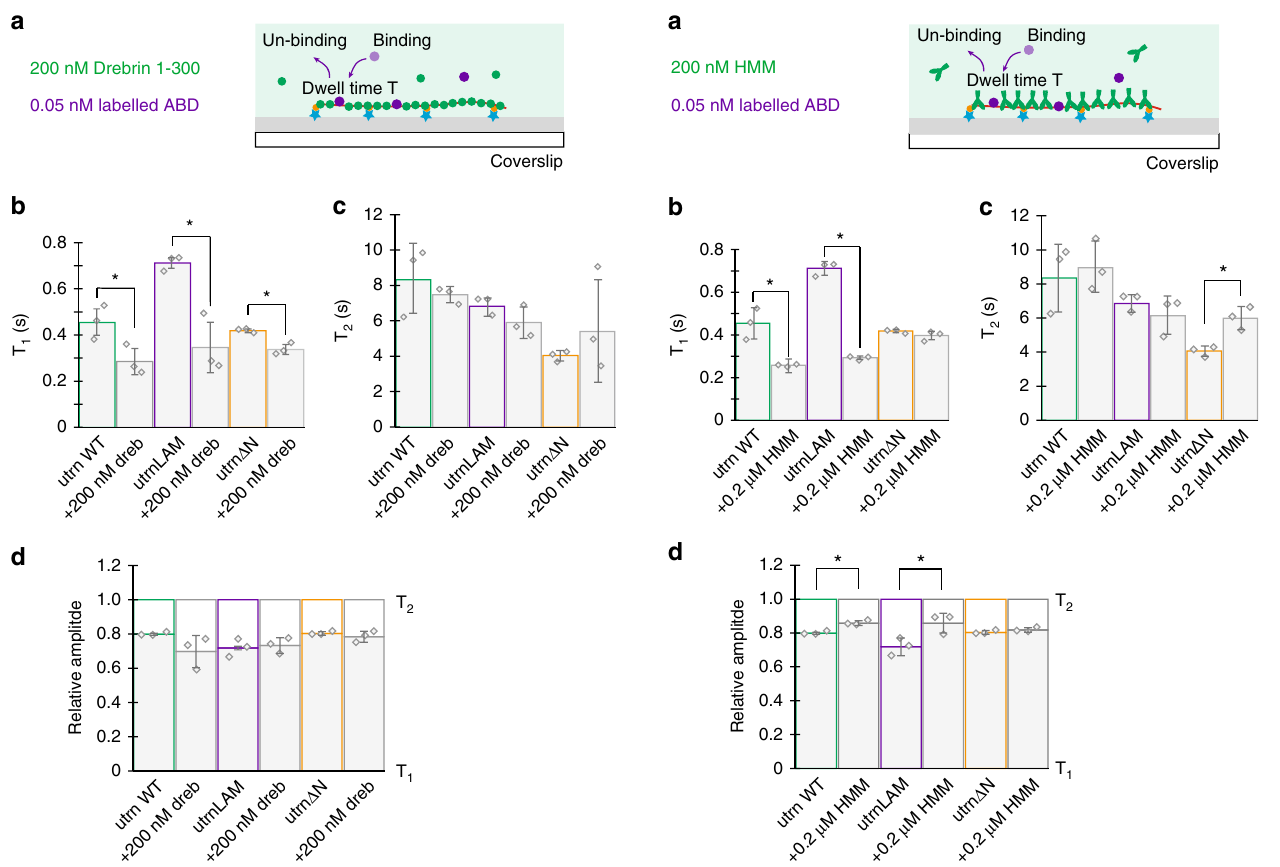
Fig. 5 Filament binding by drebrin alters utrophin ABD mutant dwell times. a Single molecule binding kinetics in the presence of 200 nM of the actin-binding domain of the protein drebrin (drebrin 1 – 300). Comparisons of the fi rst timescale b second timescale c and relative amplitudes d from a double exponential fi t to the cumulative distribution functions for the different constructs. Error bars are the standard deviation around the mean of 3 technical replicates. Conditions were compared using a two-tailed students t -test, with p < 0.05 denoted by a star (*).